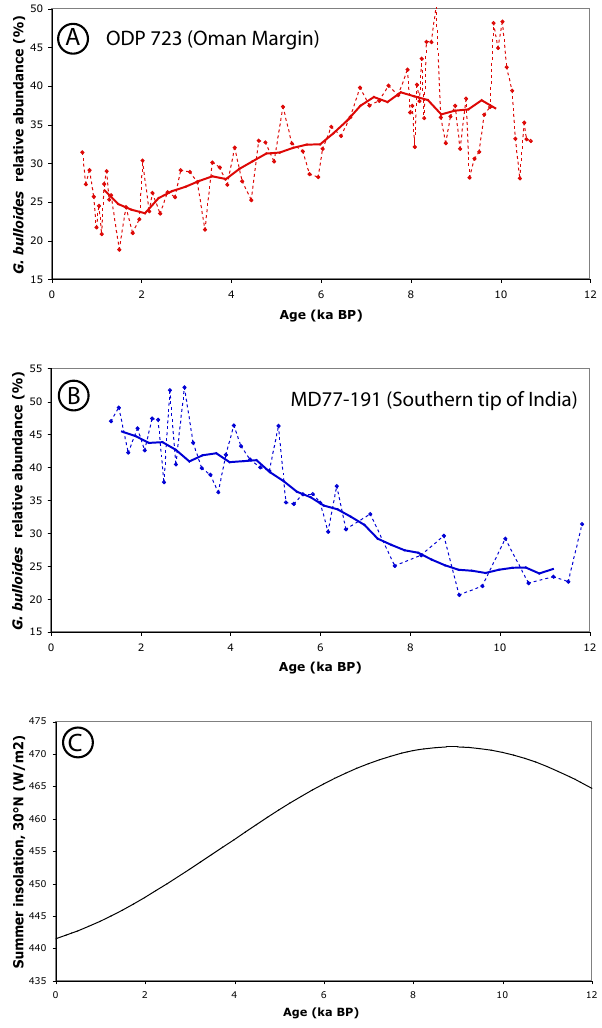
Fig. 4. (A) G. bulloides percentages versus age in ODP Site 723 (Oman Margin; Gupta et al., 2003). (B) G. bulloides percentages versus age in core MD77-191 (southern tip of India; Mladeck- Vautravers, 1997). (C) Boreal summer insolation at 30 ◦ N over the last 12kyr. Dashed-line curves represent % G. bulloides data re-sampled at a constant, 0.3kyr interval. The thick-line curves rep- resent smoothed records (5-point moving